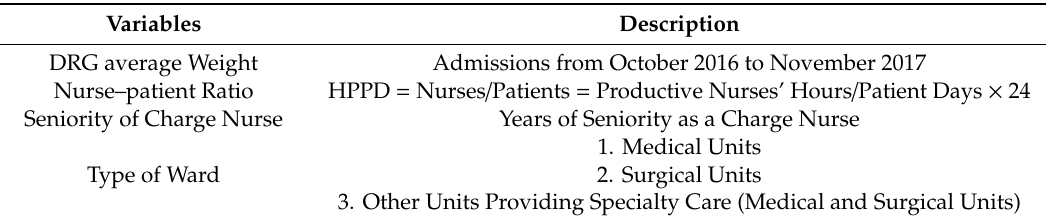
Table 1. Description of study variables.